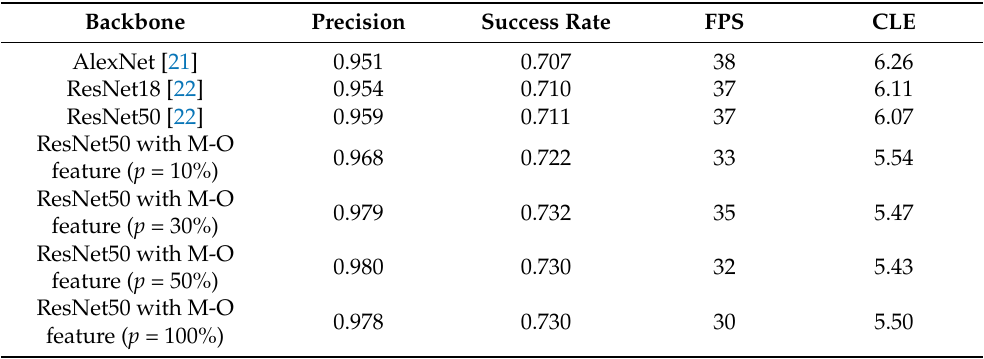
Table 2. Ablation studies on the backbone of M-O SiamRPN with weight adaptive joint multiple intersection over union loss